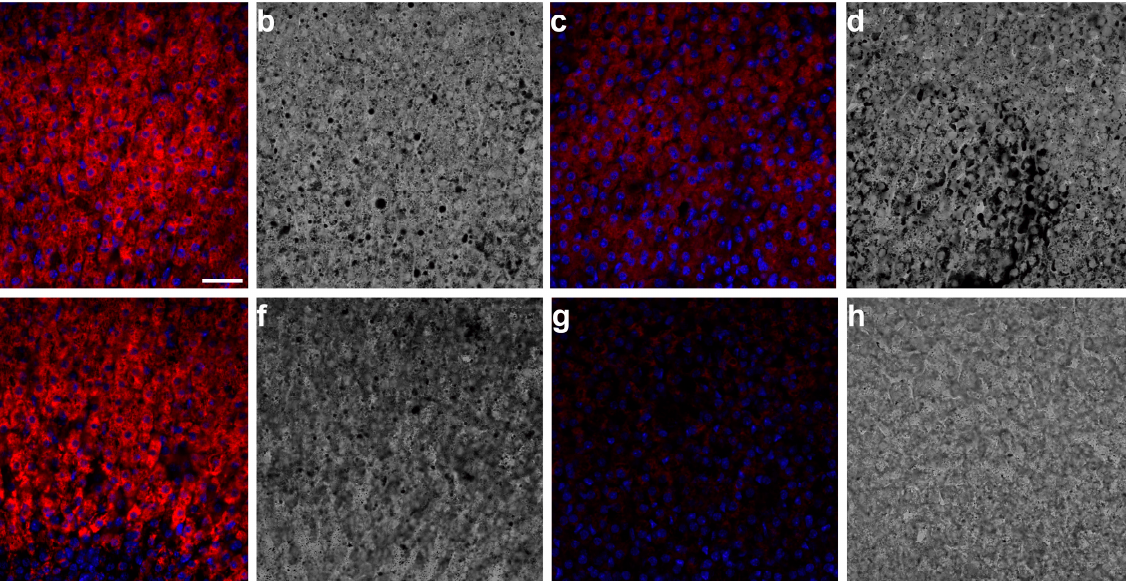
Figure 4. Immunofluorescence staining of fixed adrenal cortex tissue sections treated with TrueBlack or MaxBlock. Mouse adrenal tissue sections stained with DAPI, rabbit anti-CYP21A2 primary antibody, and goat anti-rabbit IgG H&L (Alexa Fluor TM 594) secondary antibody. CYP21A1 staining in tissue sections treated with TrueBlack before ( a ) or after immunostaining ( c ) and the correspond- ing transmitted images ( b and d , respectively). CYP21A1 staining in tissue sections treated with MaxBlock before ( e ) or after immunostaining ( g ) and the corresponding transmitted images ( f and h , respectively). Images were taken with Olympus FluoView™ FV3000 using 405, 488, and 561 nm excitation and 430–470, 500–540, and 570–670 nm detection ranges, respectively. Fluorescence images ( a , c , e , g ) show the overlay of the three observed channels. Transmitted images were taken simul- taneously at 561 nm excitation. Bar: 30 μ m. Abbreviations: DAPI, 4 ′ ,6-diamidino-2-phenylindole; TrueBlack, TrueBlack TM Lipofuscin Autofluorescence Quencher; MaxBlock, MaxBlock TM Autofluo- rescence Reducing Reagent Kit.